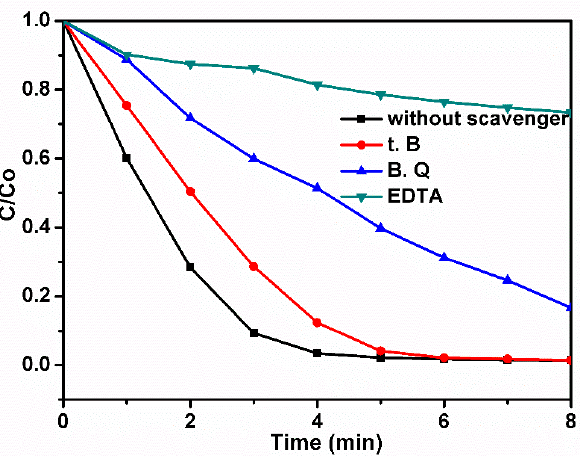
Figure 9. The effect of reactive species on the degradation of MB over CNT-COO − /Ag 3 PO 4 @AgIO 4 -5% composite under simulated light